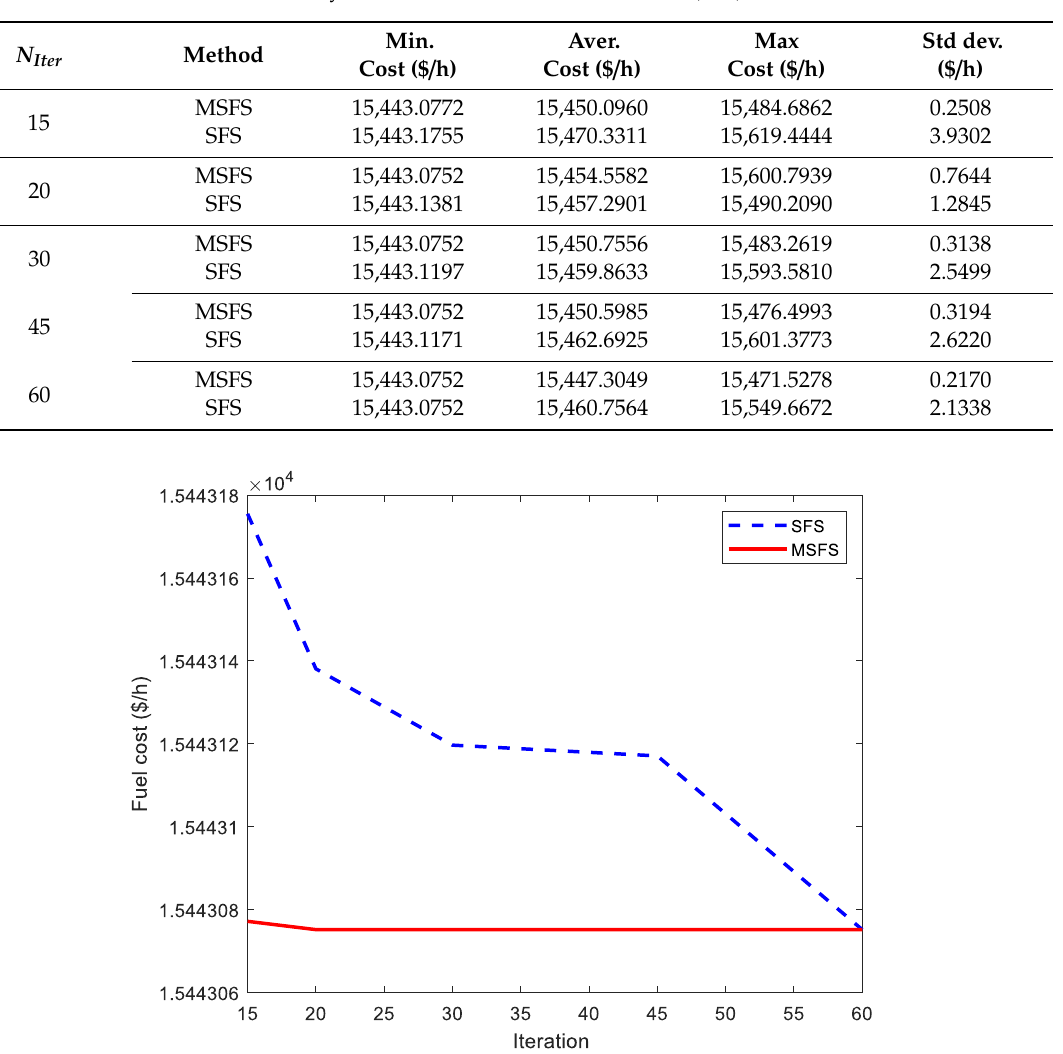
Table 4. Results obtained by MSFS and SFS methods for the rest of the cases.